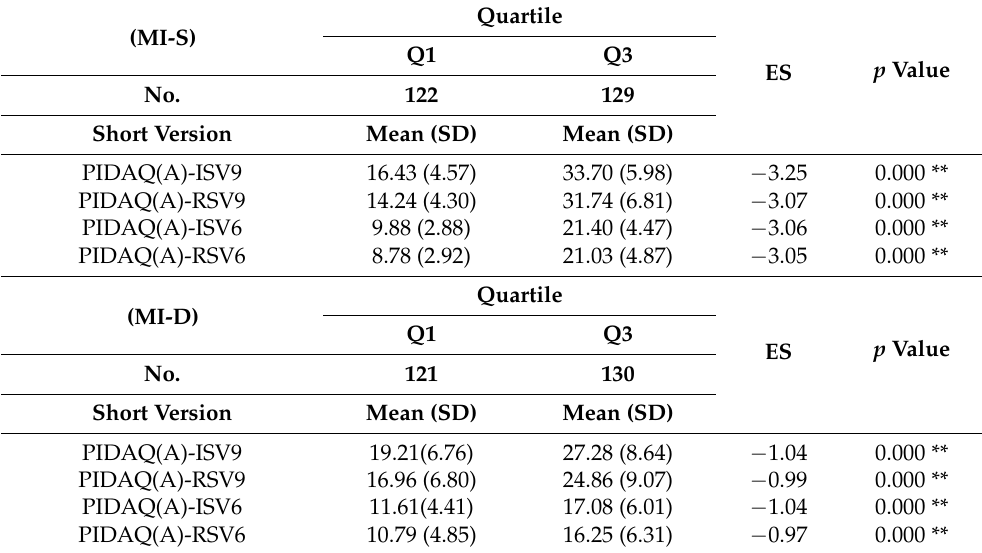
Table 12. The discriminant validity: all short versions in association with self-rated (MI-S) and interviewer-rated (MI-D) malocclusion (n =